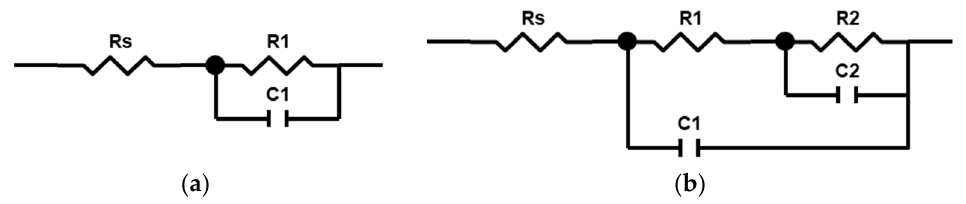
Figure 8. Equivalent circuit for the fitting of the in situ impedance spectra of Ti PEO at different stages: ( a ) 30 s; ( b ) 60–300 s. Table 1. Equivalent circuit fit results for the in situ impedance spectroscopy of Ti PEO.